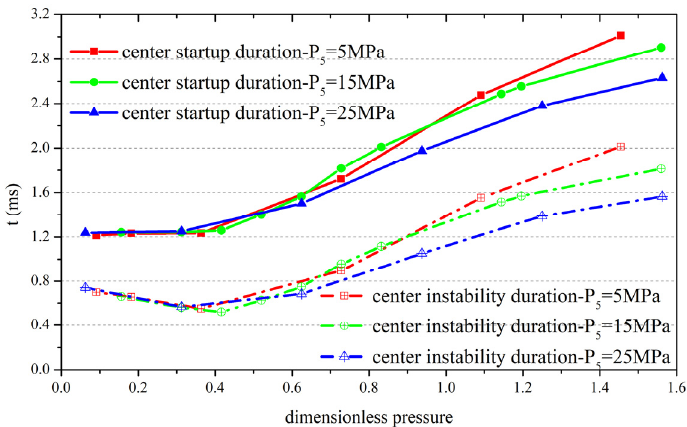
Figure 14. The center startup time and instability time of the nozzle variation with the dimensionless pressure ( T 5 = 6000 K) (The dimensionless pressure is equal to the ratio of the initial pressure to the pressure at the outlet of the nozzle when the flow field is stable).